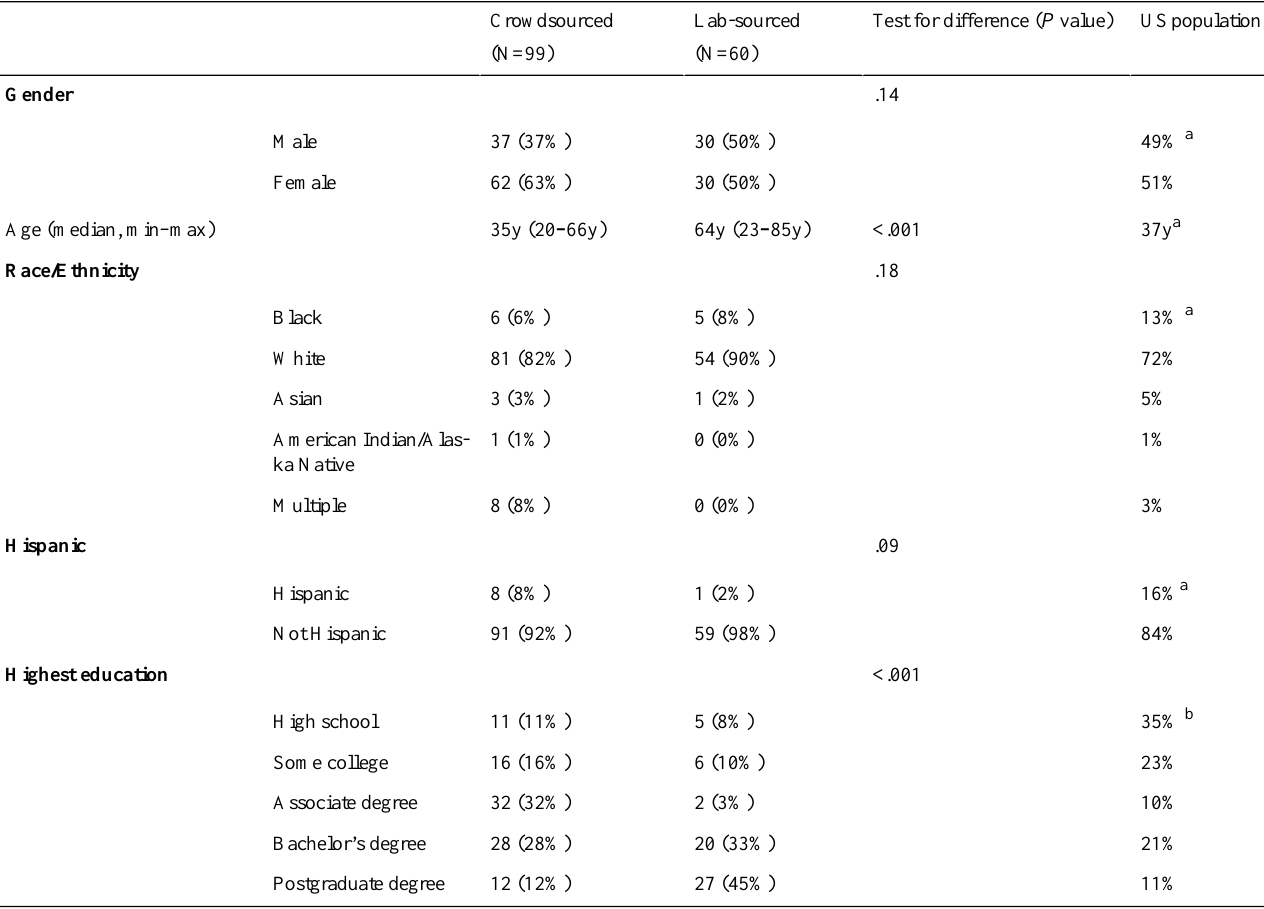
Table 1. Self-reported demographic characteristics of